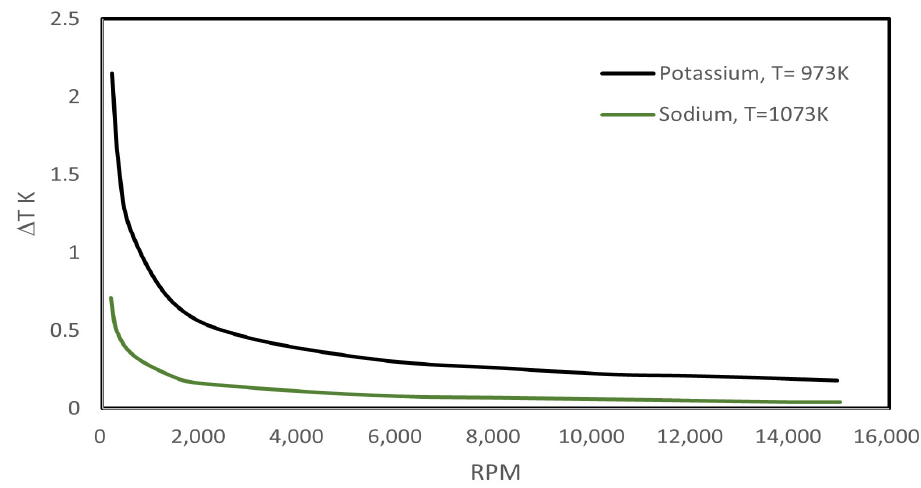
Figure 8. Temperature drop across the condensate film as a function of rotational speed (data from [46]).